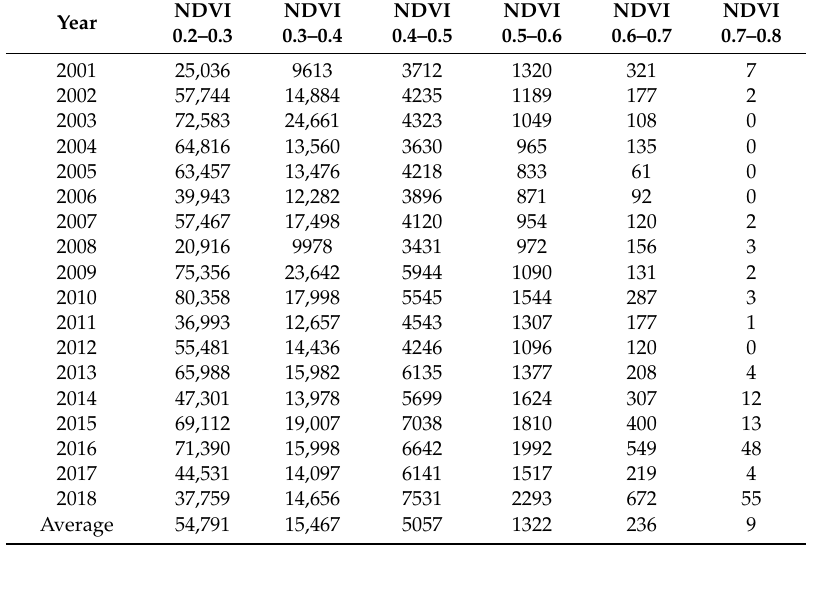
Table 2. The area covered by di ff erent NDVI categories (km 2 ) in Afghanistan between 2001 and 2018.